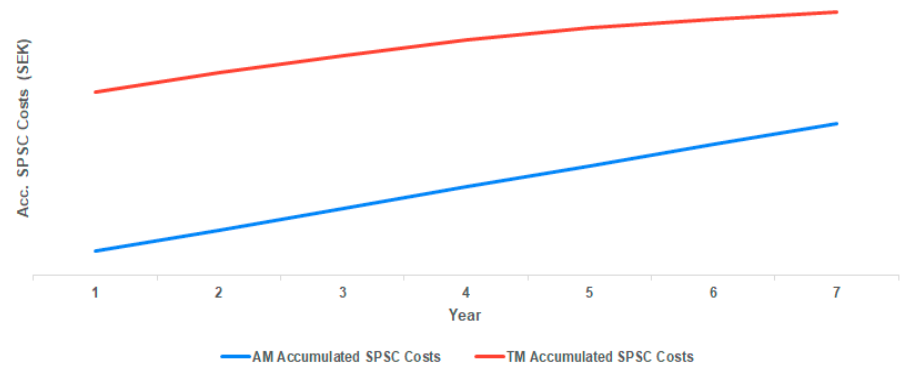
Figure 6. AM and TM accumulated SPSC costs for P2 over the seven-year planning horizon.